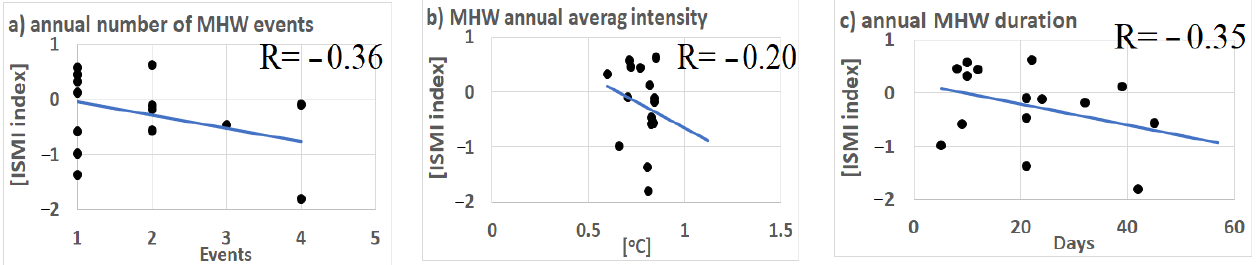
Figure 8. Scatter plots of bi-monthly multivariate ENSO index (MEI.v2) and annual number of MHW events ( a ), MHW annual average intensity ( b ) and annual MHW duration ( c ) during MHW events.